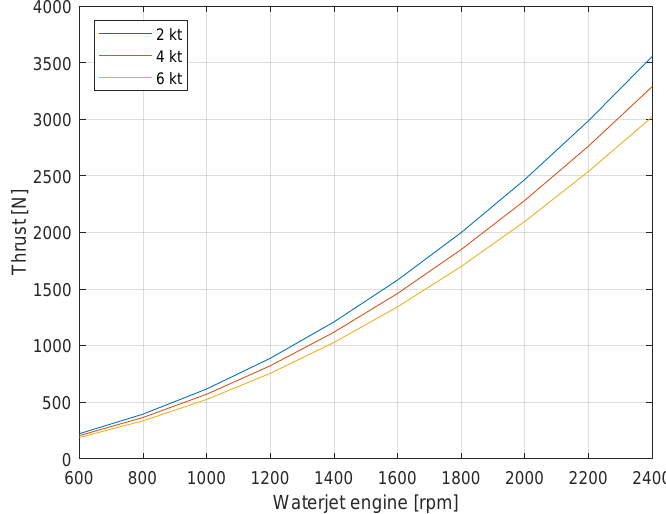
Figure 2. Thrust force F generated by the waterjet propulsion system depending on the shaft rotational speed N